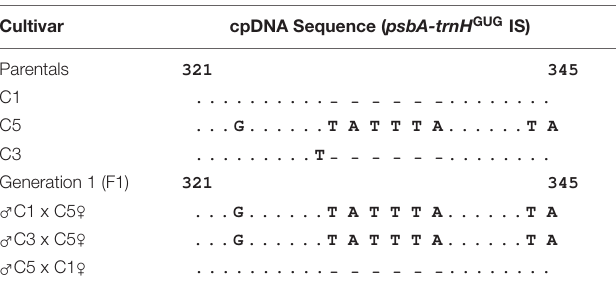
TABLE 1 | Alignments of psbA-trnH GUG Inter-Genic Spacer sequences (nucleotides 321–345) from Colombian cultivars of Sacha inchi. Cultivar cpDNA Sequence ( psbA-trnH GUG